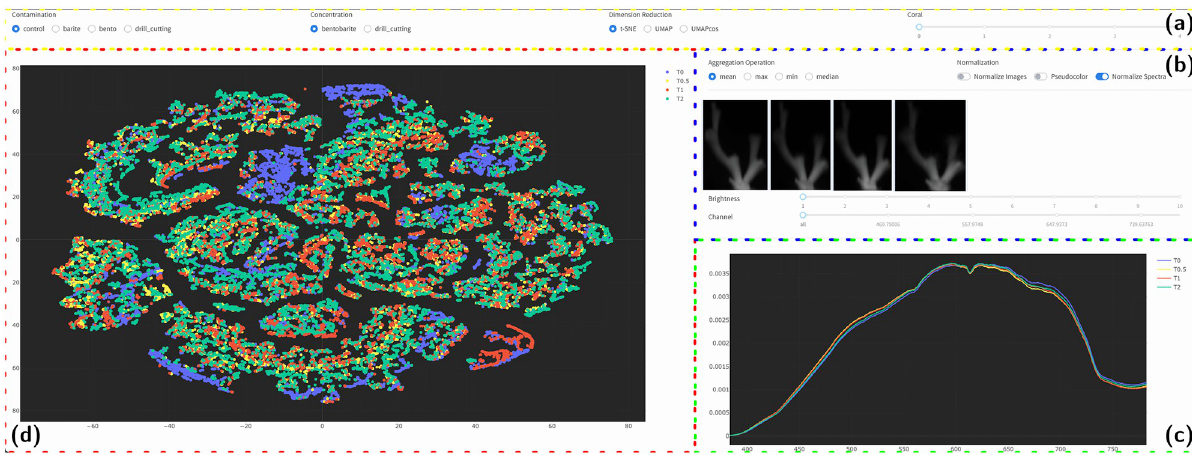
Fig 2. Screenshot of the HypIX tool: In the top frame (a) the experimental conditions, concentration levels, dimension reduction algorithms and individual coral samples (0, ... , 4 or 5) can be chosen by the user. On the right (b) a pseudo image of each HSI of all four time steps is shown in the image display , in this case the mean spectral response value (see Methods for details). On the right side in frame (b) the user can chose to apply image normalization or use pseudocolor to change the images visualization. In frame (c), spectral signatures from all four time steps are shown in the spectra display . This window initially shows the agglomerated spectral signatures from all four data sets color encoded (T0: blue, T0.5: yellow, T1: red, T2: green. (d) The large frame on the left (d) shows the dimension reduction results for the four HSI data sets in the embedding display using again the same color code for the four time